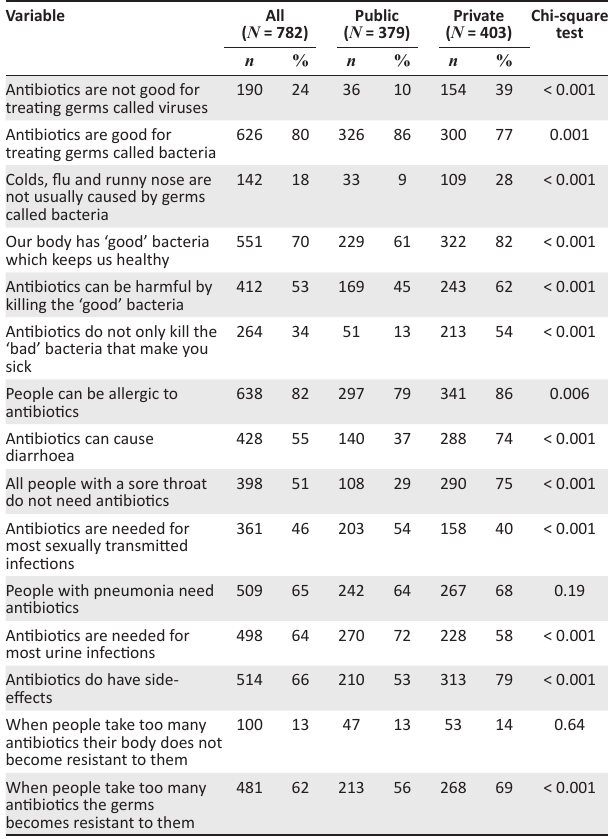
Table 3 explores the associations between knowledge